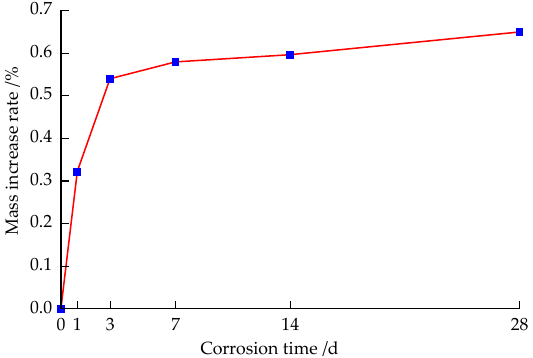
Figure 3. Increase rate of sandstone mass after solution corrosion.